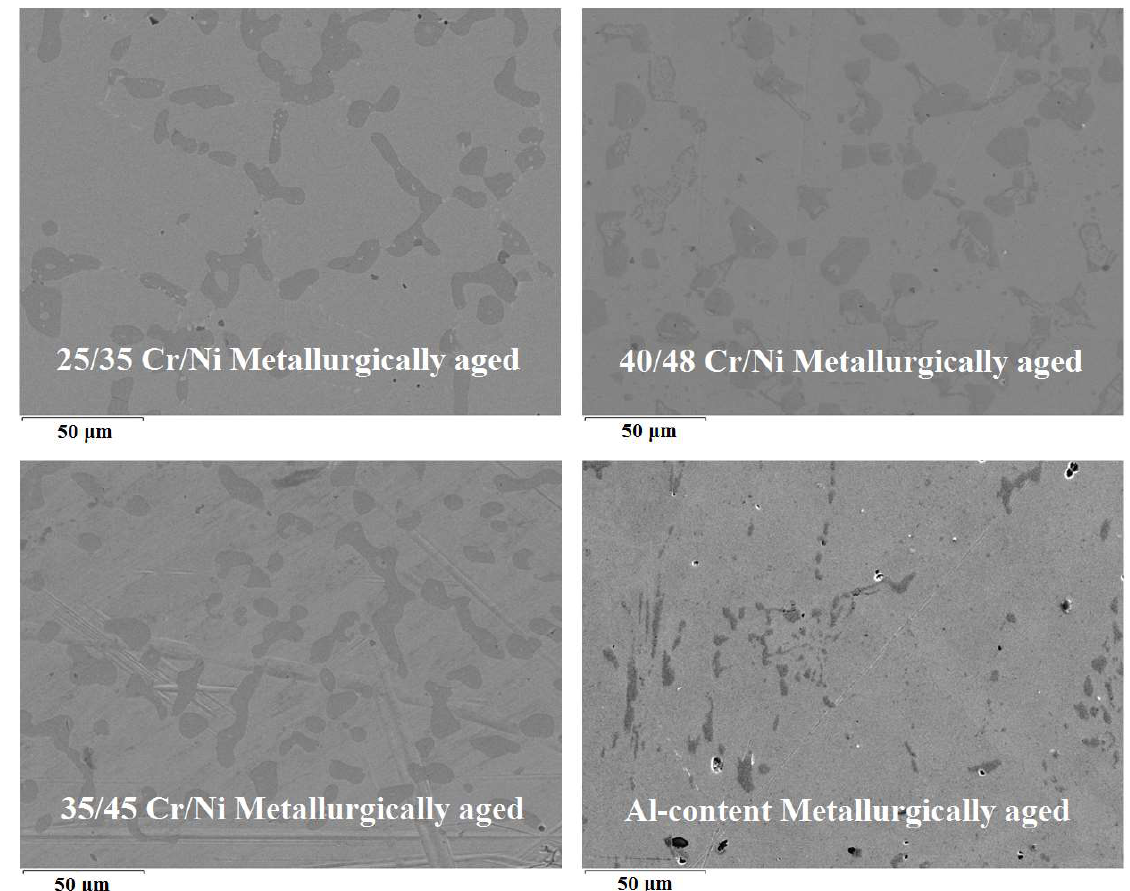
Figure 12. Microstructure SEM pictures after metallurgic aging. Magnification: 550 × , Accelerating Voltage: 15 kV. Dark grey.